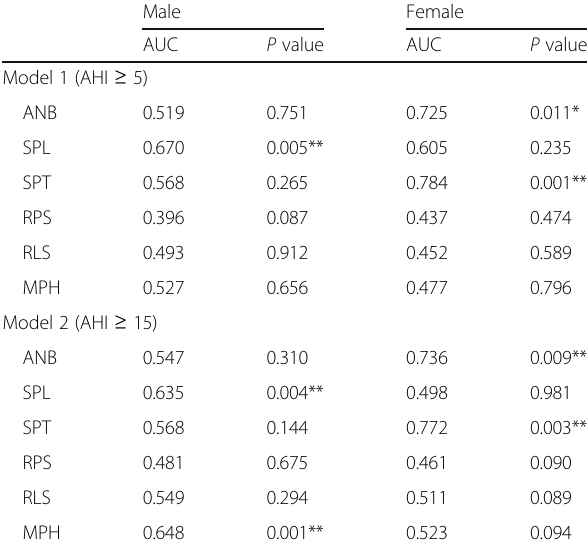
Table 5 Comparison of areas under the receiver operating characteristic curves in male and